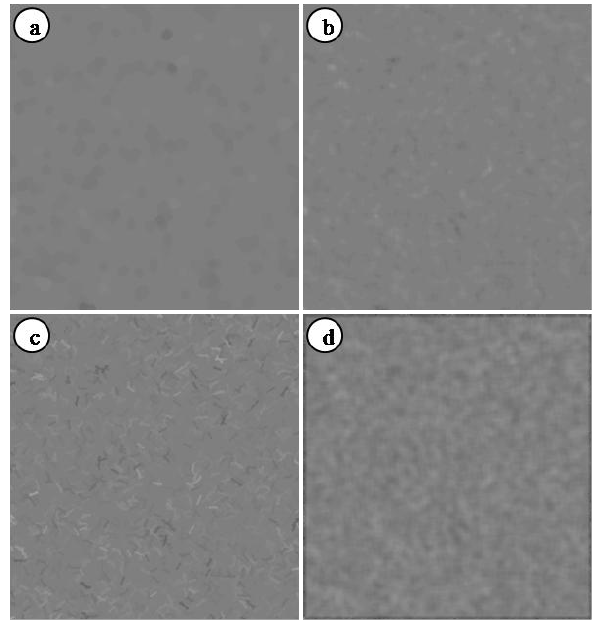
Figure 2. Results of the filtration of homogenous image with simulated speckle, using: a) SAF, b) Median filter, c) MSE filter, d) Lee filter (filter window size: 5)